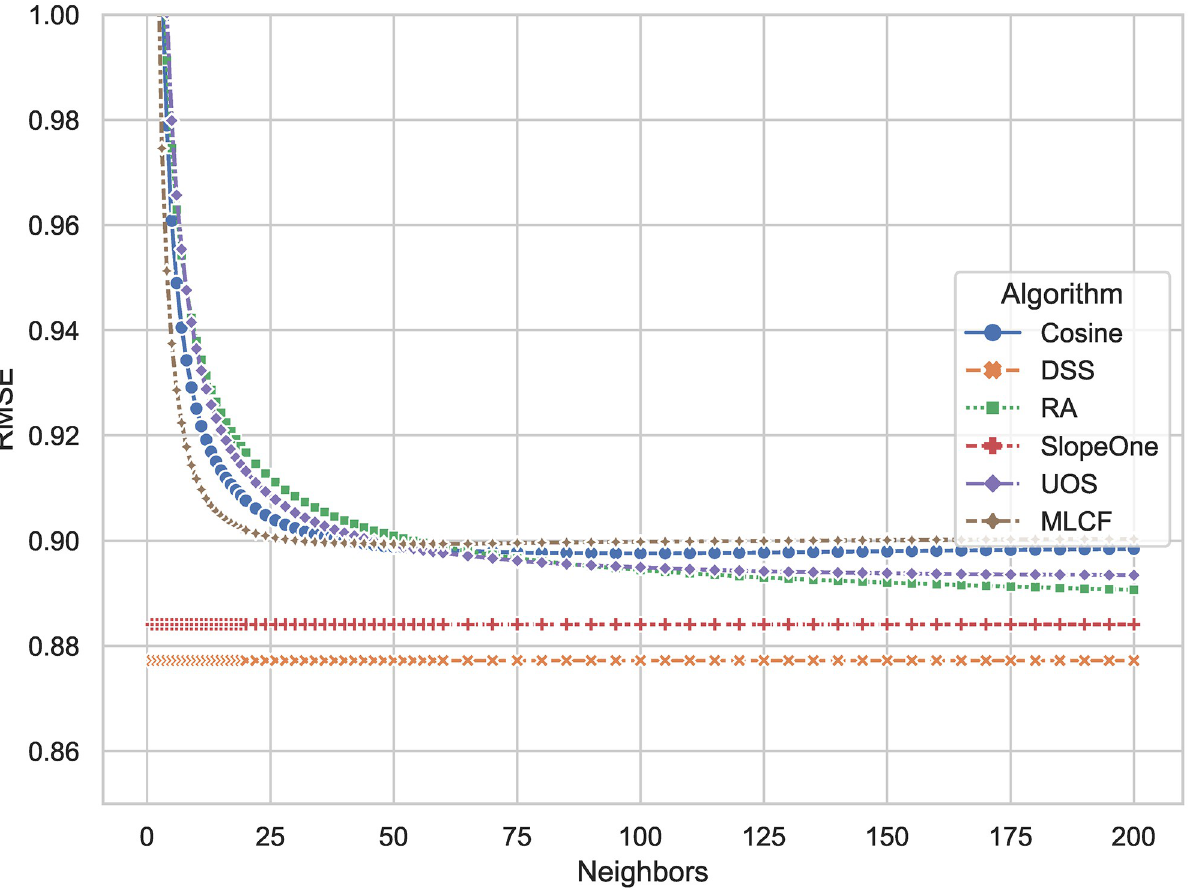
Fig 4. RMSE comparison results of DSS and other algorithms. The smaller the result, the smaller the prediction error of the algorithms on the rating.